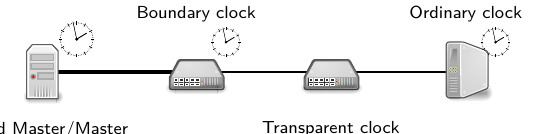
Figure 1. PTP hierarchy. The clock symbol specifies which nodes are synchronized with each other using